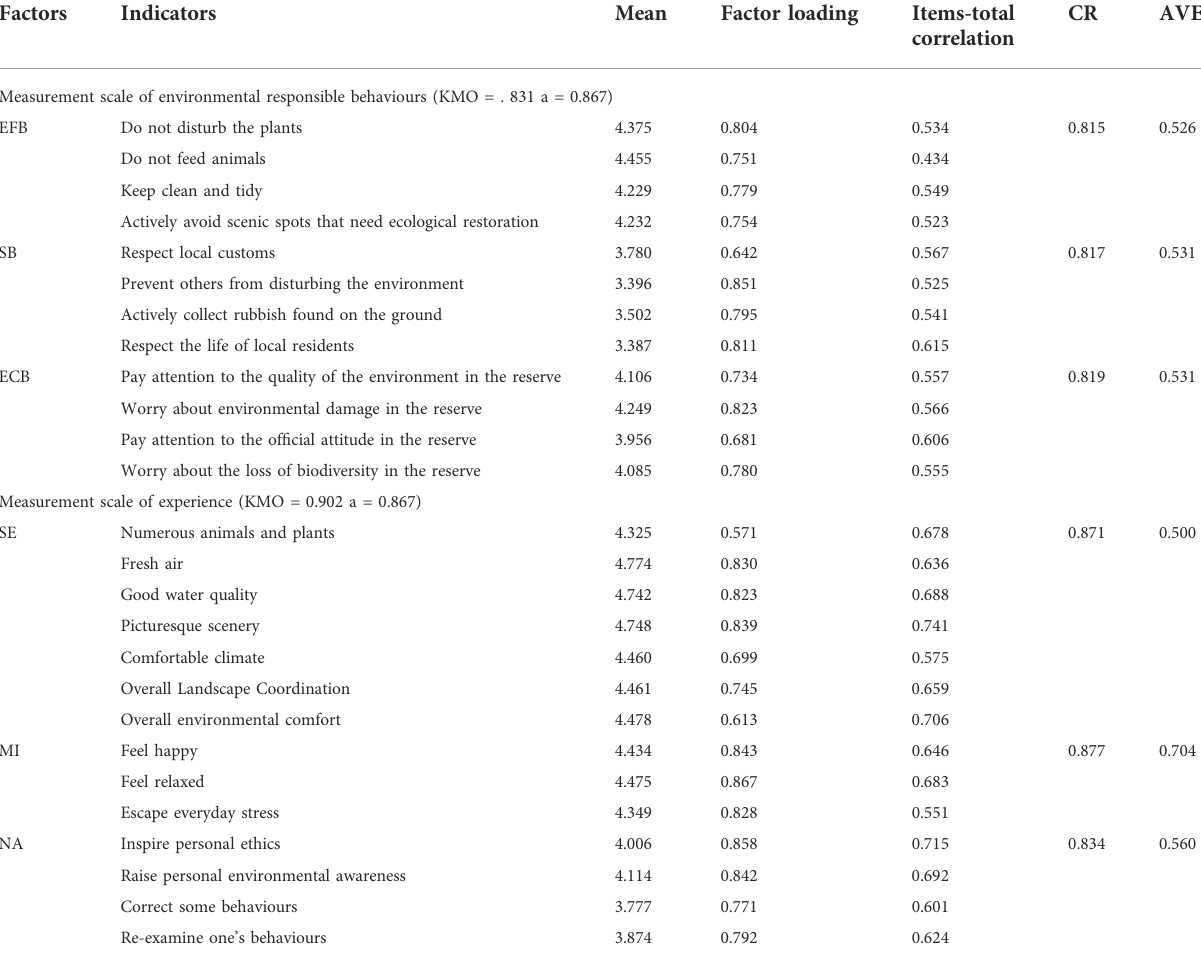
TABLE 1 Construct measurement summary.